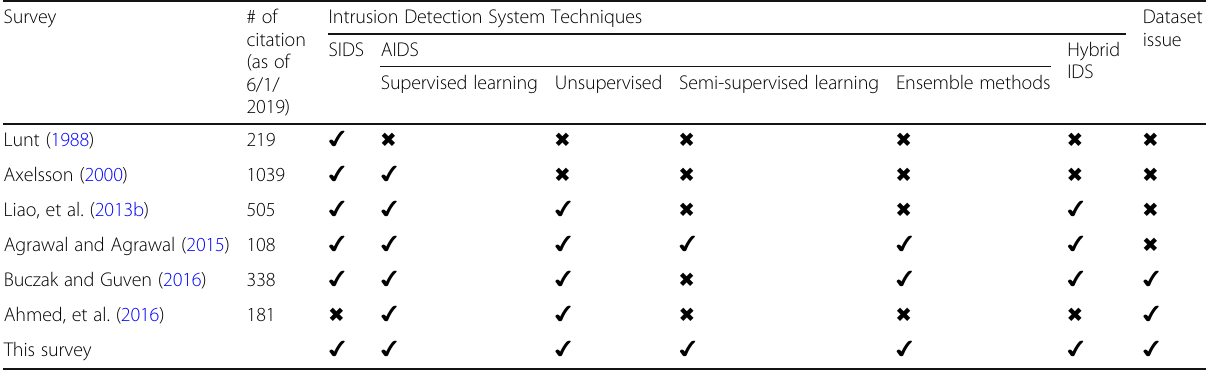
Table 1 Comparison of this survey and similar surveys: ( ✔ : Topic is covered, ✖ the topic is not covered) Survey # of citation (as of 6/1/